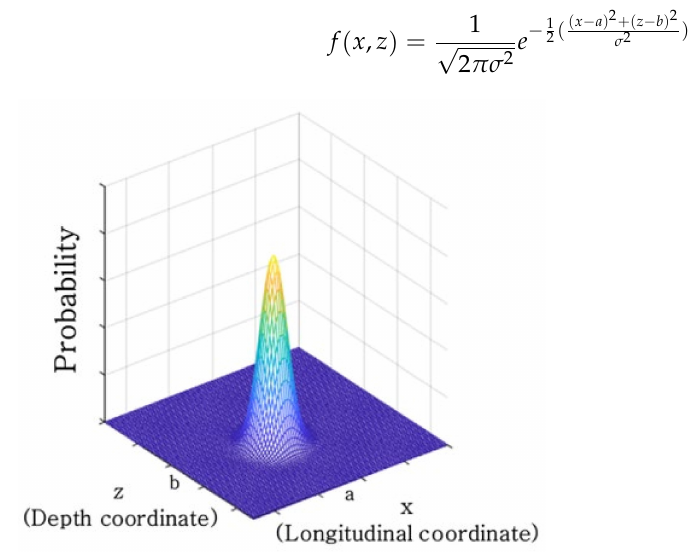
Figure 3. Probability function applied to predict the location of the damage